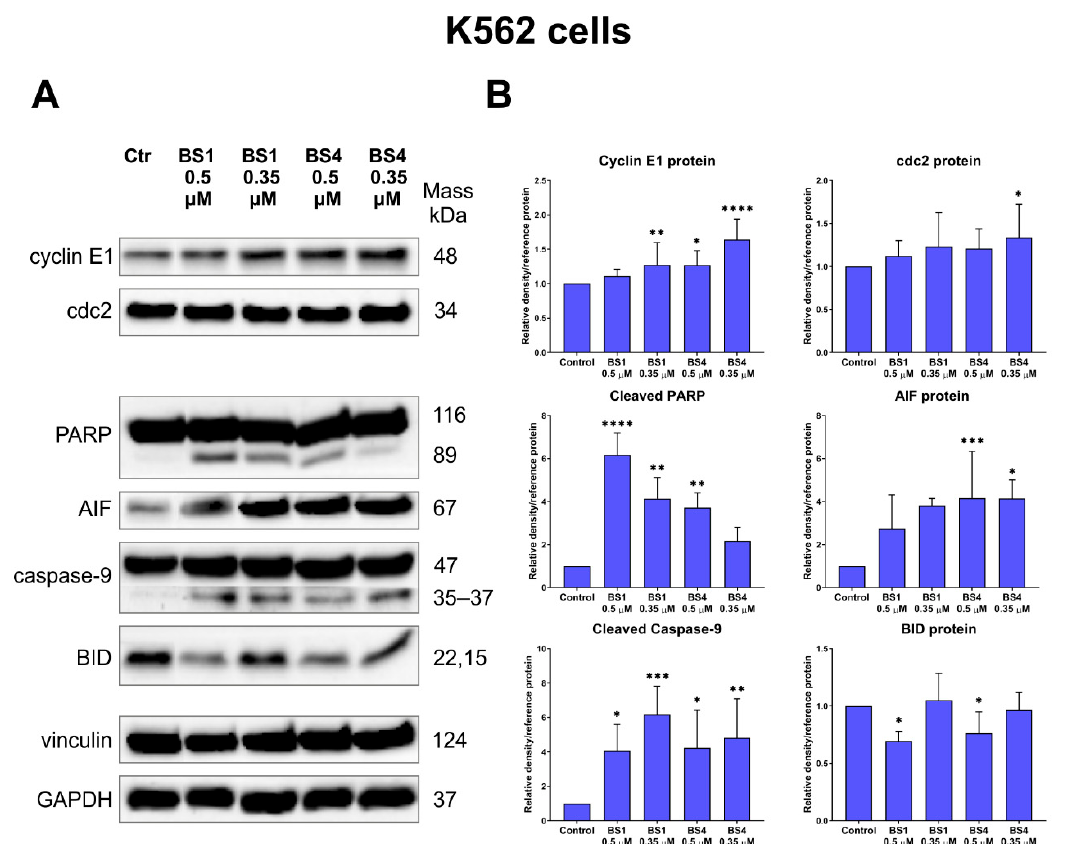
Figure 9. Impact of the tested derivatives ( BS1 , BS4 ) at various concentrations on the expression of selected proteins that are associated with the cell cycle and apoptosis in the K562 cells ( A ). The densitometric analysis charts of the obtained results were normalized to the reference protein and are presented as the mean ± SD of several independent experiments. The uncropped Western blots have been shown in Figure S22. ( B ). The statistical analysis was performed using a one-way ANOVA with Bonferroni’s post-hoc test: * p < 0.05, ** p < 0.01, *** p < 0.001, **** p < 0.0001 compared to the untreated cells (control, Ctr).